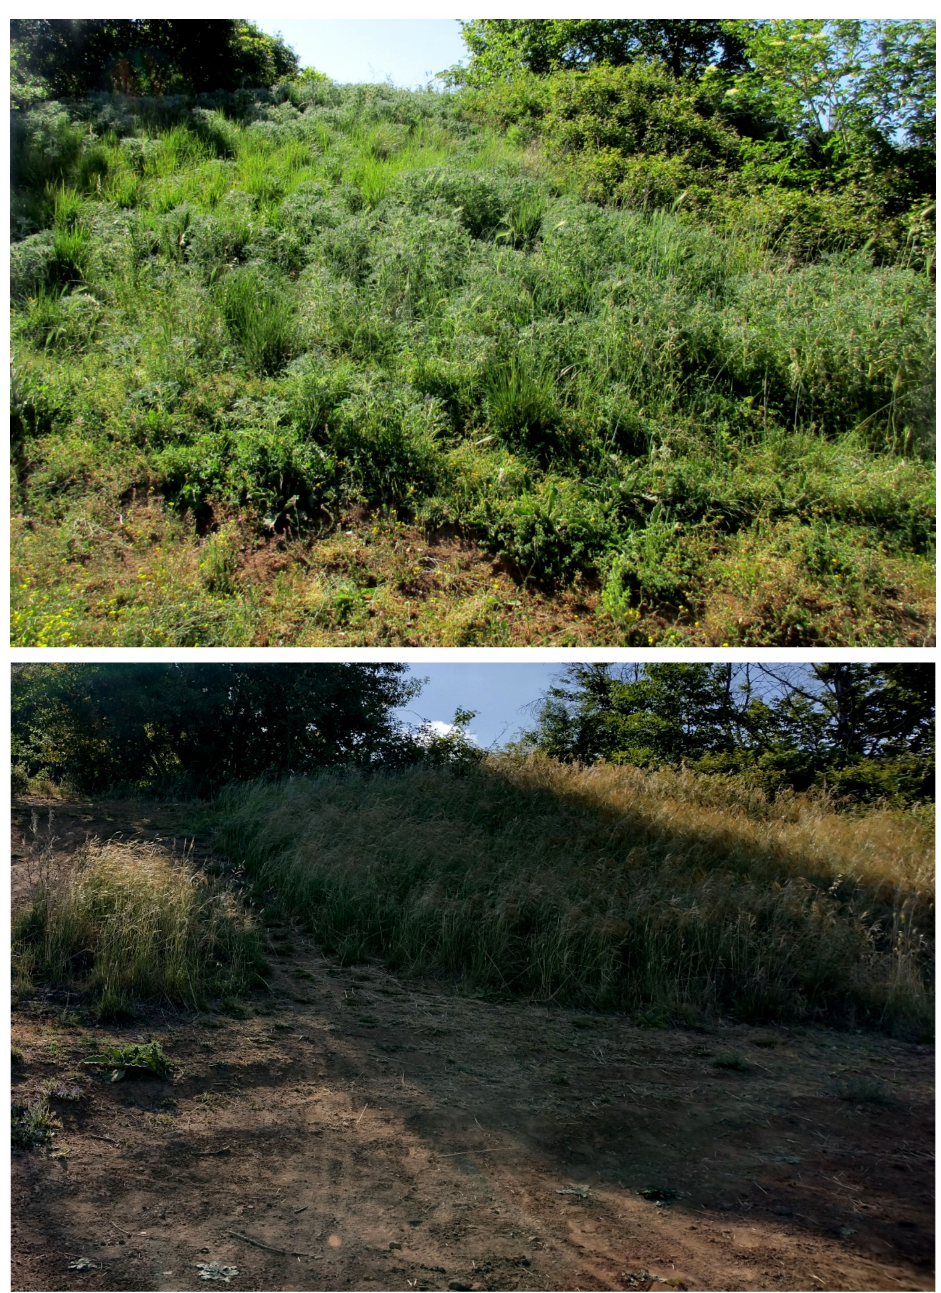
Figure 78. Lupinus albus subsp. graecus in Caffarella valley: population lost ( top photo, dated 2017); Nassella neesiana dominated community ( bottom photo, dated